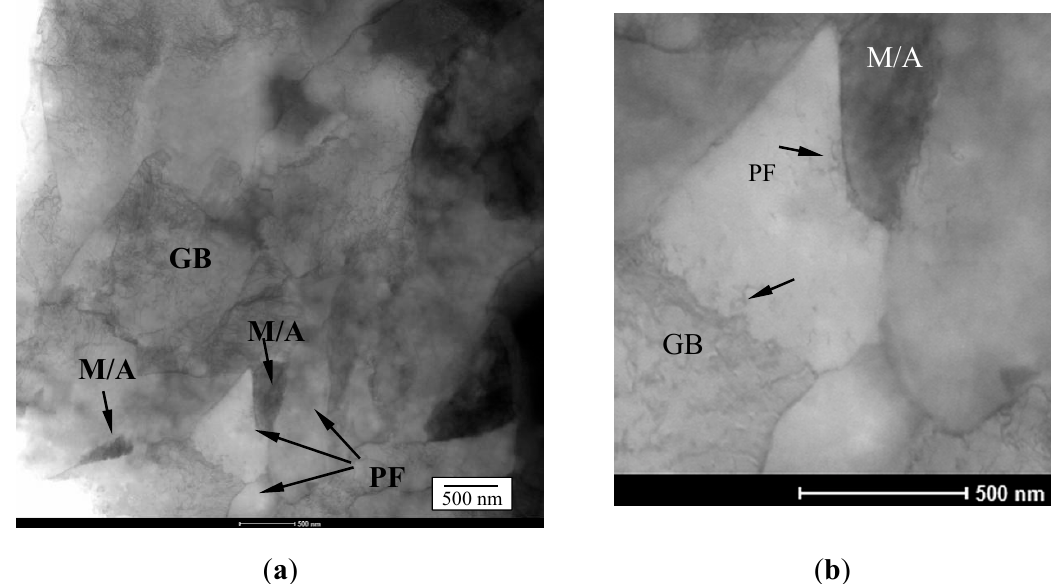
Figure 5. ( a ) TEM micrographs showing GB and PF. GB has much higher dislocation density than PF. ( b ) shows an enlarged view of PF; the arrows show the slight dislocations developed in PF at the interface with M/A and GB. The processing parameters are as that of Figure 4.